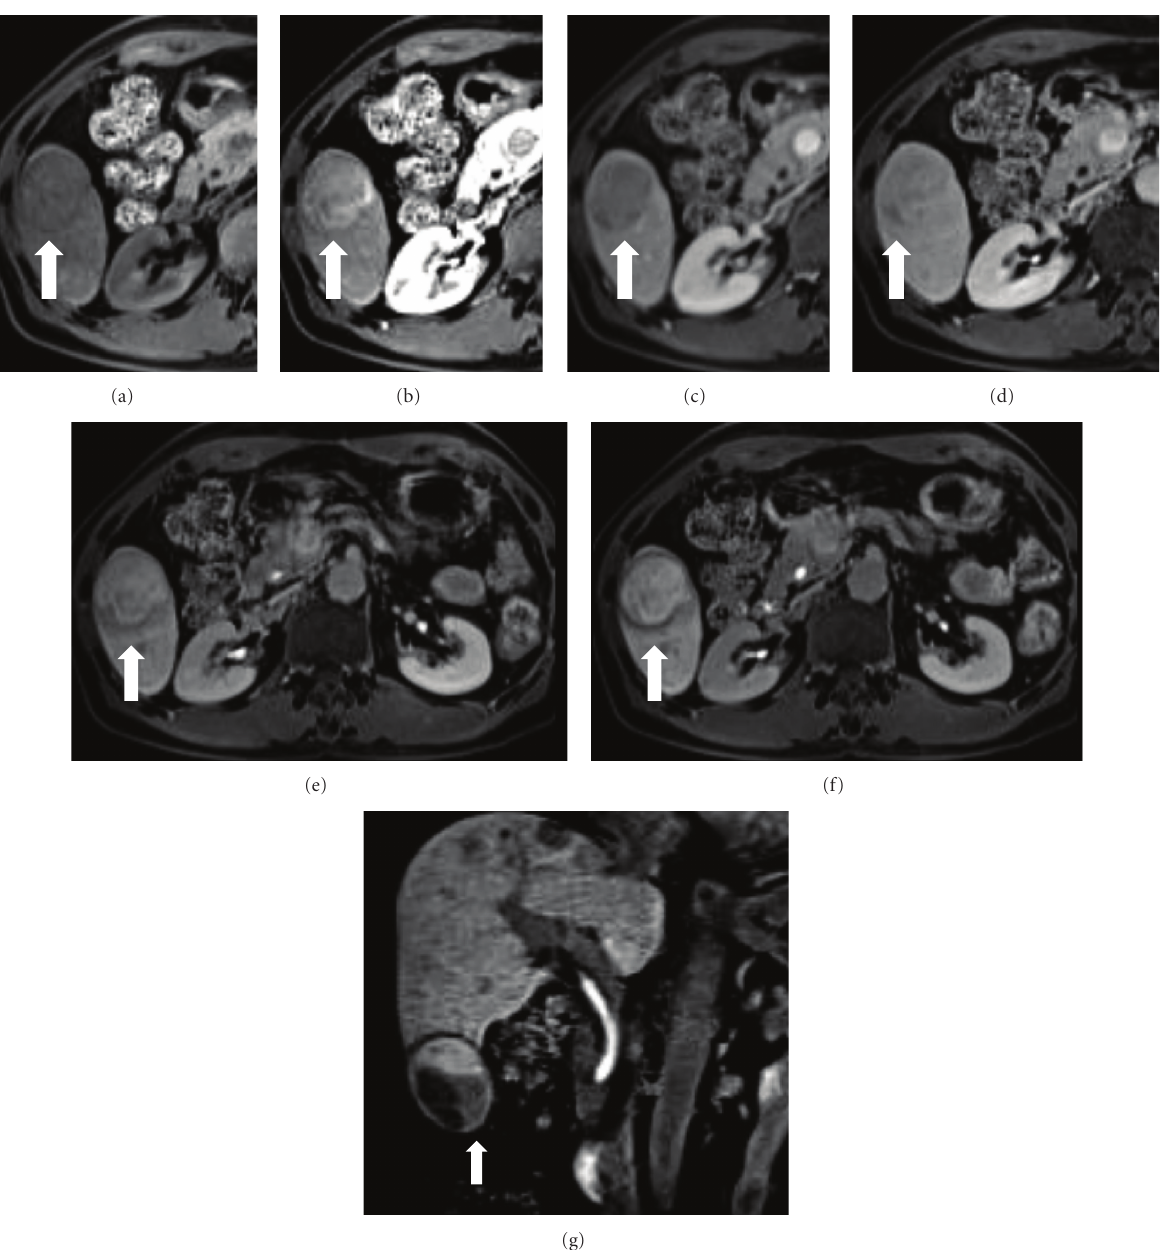
Figure 3: (a–d) Gadoxetate acid-enhanced MRI in the precontrast, arterial, venous, and equilibrium phases of Hepatitis B virus carrier showing a nodule in segment 6 of the liver with early arterial enhancement and late-phase washout compatible with HCC. (e), (f) Gadoxetate acid-enhanced MRI in the hepatobiliary phase 10–20 minutes after injection, showing progressively hyperintense portions of the nodule, implying lesional uptake, in a heterogeneous pattern. Note the hypointense pseudocapsule. Final surgical histopathology showed moderately di ff erentiated Edmondson-Steiner grade II HCC. (g) Coronal